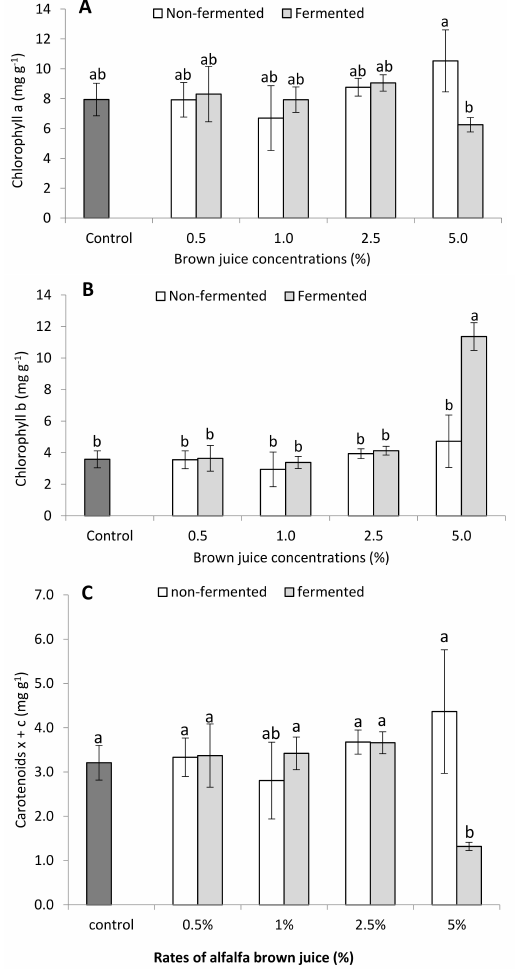
Figure 5. Effects of non-fermented and fermented alfalfa brown juice (BJ) on the ( A ) chlorophyll a, ( B ) chlorophyll b, and ( C ) (carotenoids (mg g − 1 ) content of French marigold plants ( n = 10). Different letters on the top of the bars indicate significant differences ( p ≤ 0.05). Data are presented as mean ± standard